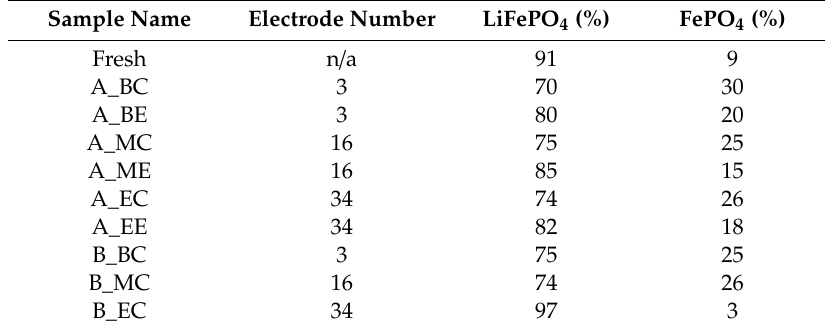
Table 5. Phase quantification obtained by XRD of fresh and aged electrode. For comparison also the value obtained for a fresh cathode (after cell formation) is reported.